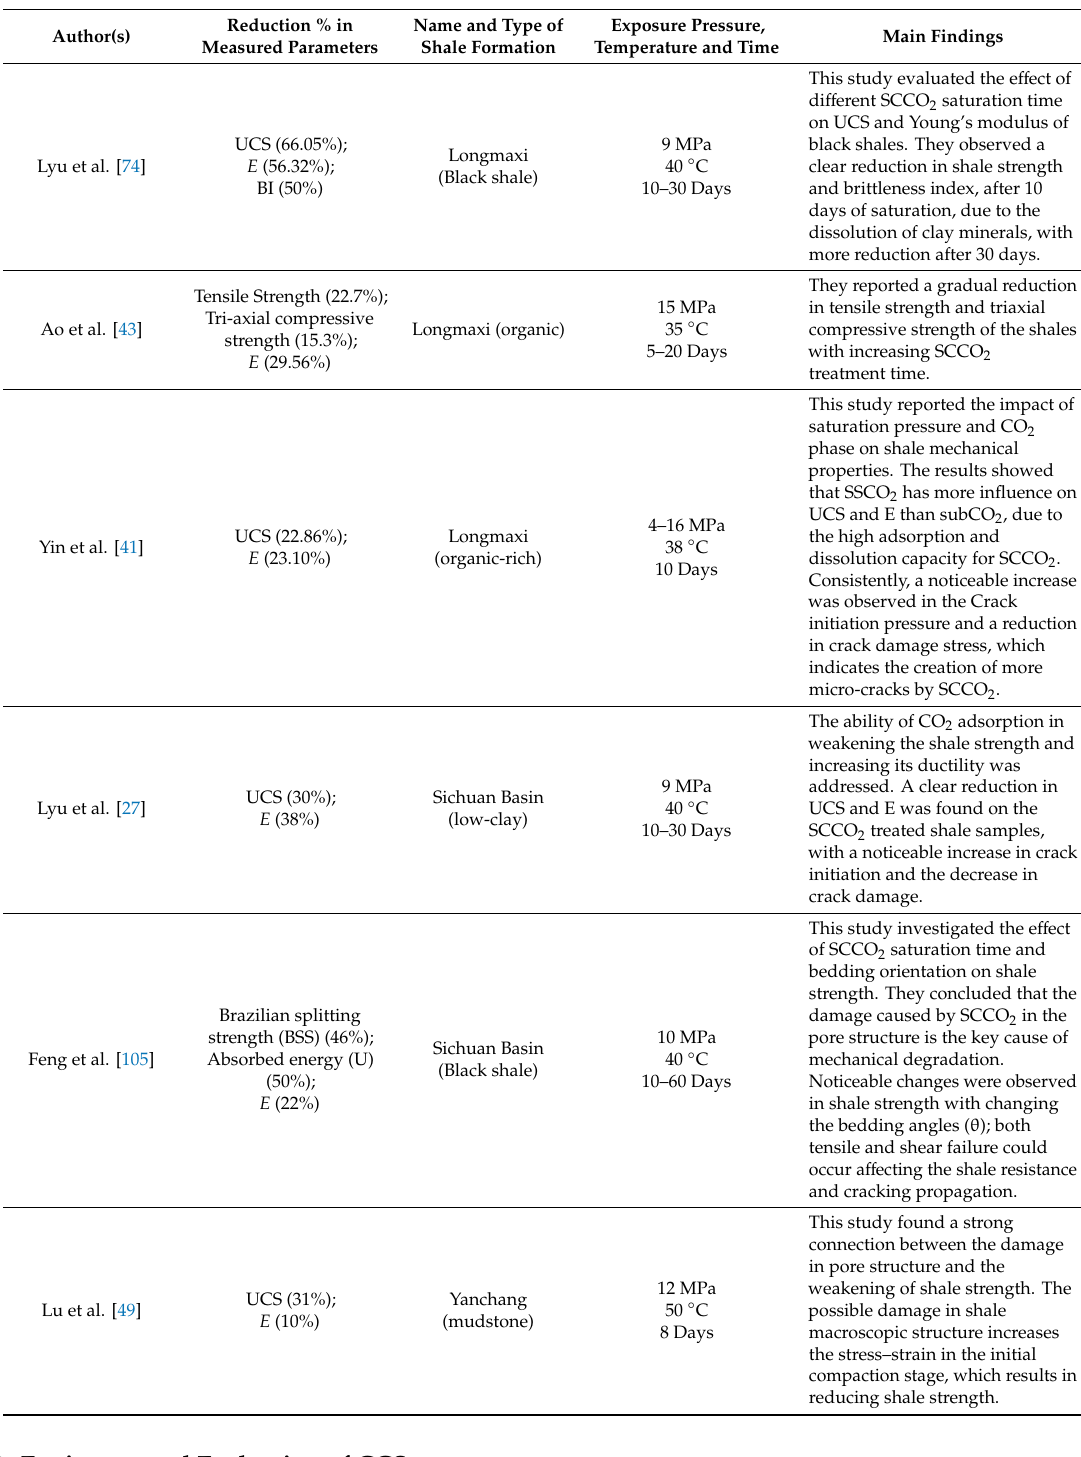
Table 4. Summary of recent studies highlighting the e ff ect of CO 2 injection on mechanical